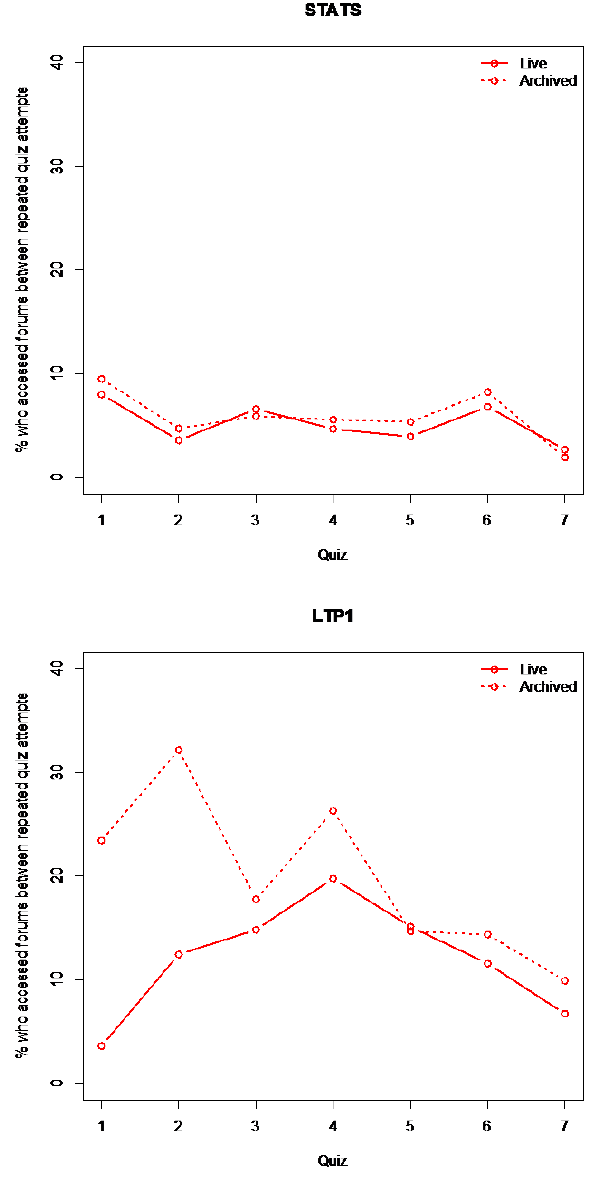
Figure 11. Percentage of learners who reattempted quizzes who accessed discussion forums between